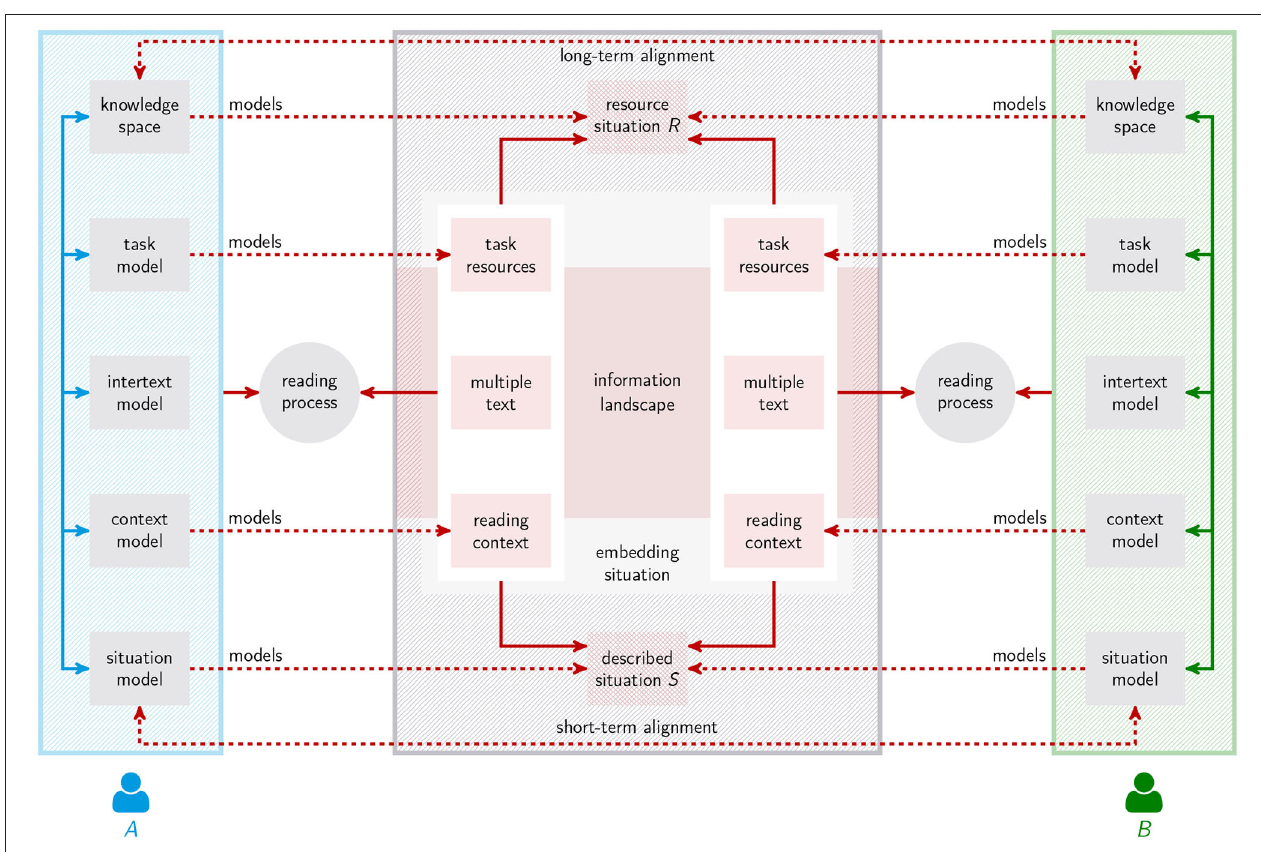
FIGURE 2 | Extending the DM in terms of alignment research.